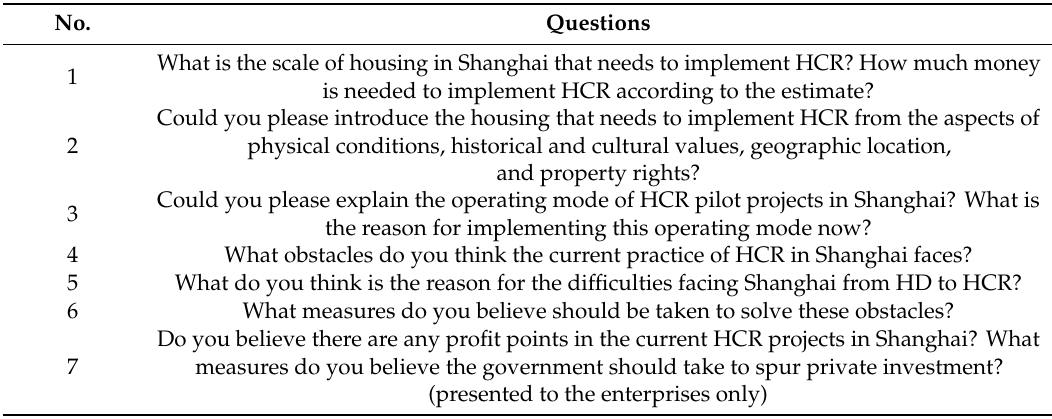
Table 1. Major questions presented to the